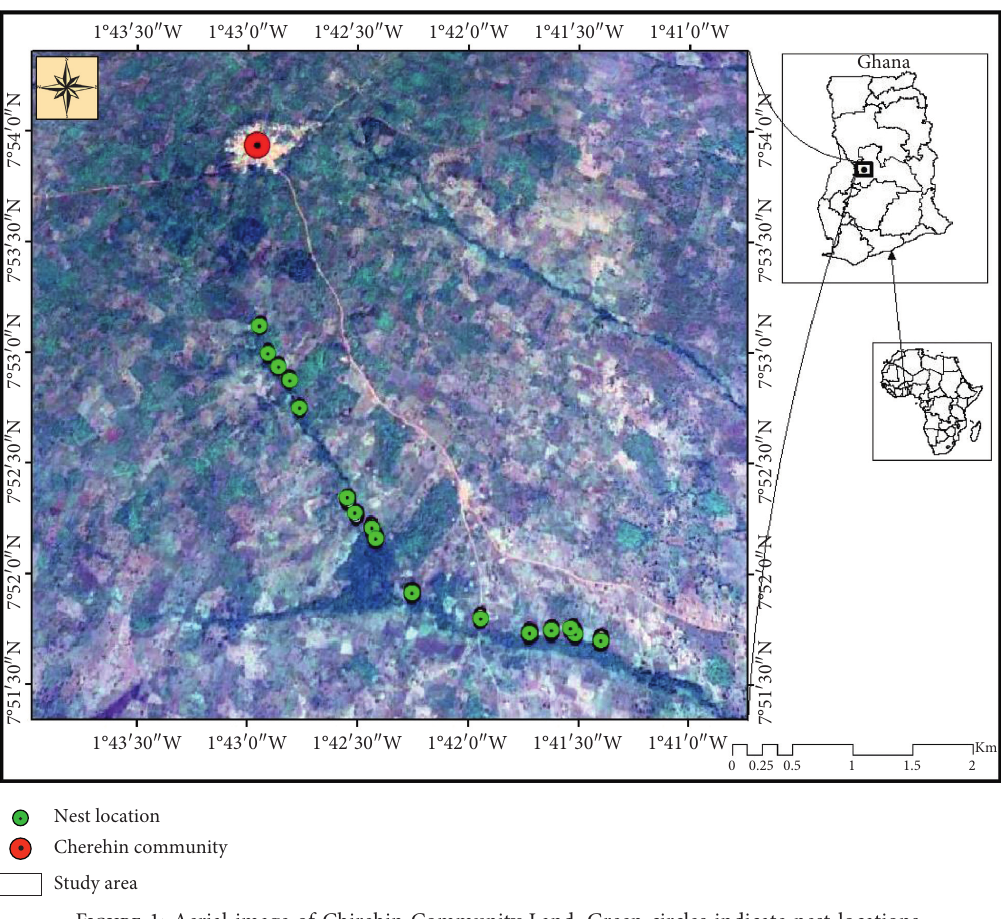
Figure 1: Aerial image of Chirehin Community Land. Green circles indicate nest